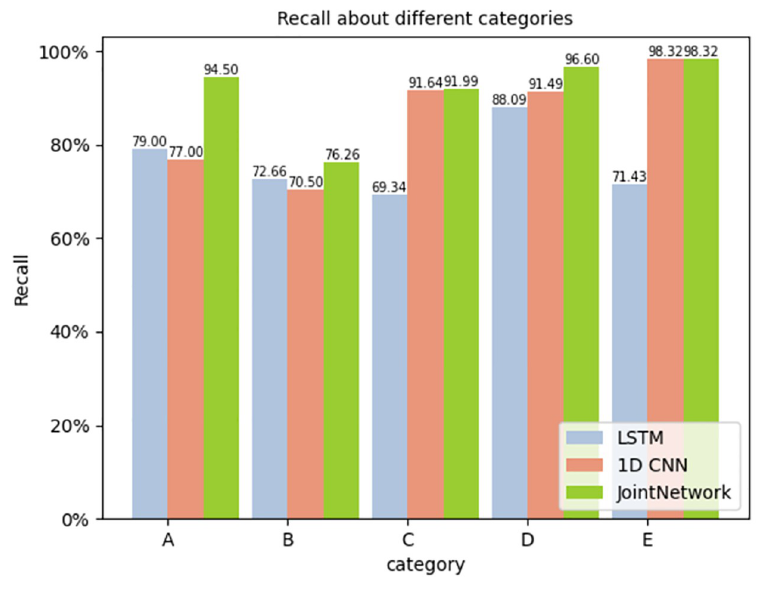
Fig 10. Recall about different categories.